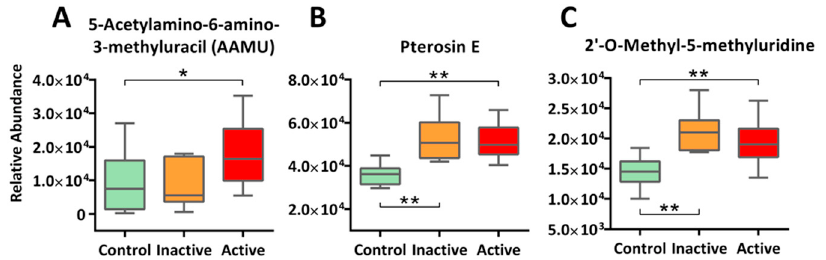
Figure 5. Other than canonical pathways, xenobiotics and novel metabolites were detected in our study at stratified levels among active Crohn’s, inactive Crohn’s, and the Control. Examples include xenobiotic marker AAMU (Panel A ) and Pterosin E (Panel B ), as well as novel metabolite 2 ′ - O -methyl- 5-methyluridine (Panel C ). The y -axis measures the peak height of the profiled metabolites, whereas the x -axis marks the three IBD groups for comparison, namely control (green), inactive (orange), and active (red), outliers, represented as dots in the boxplot, were excluded from comparison. ** p < 0.01, * p < 0.05.